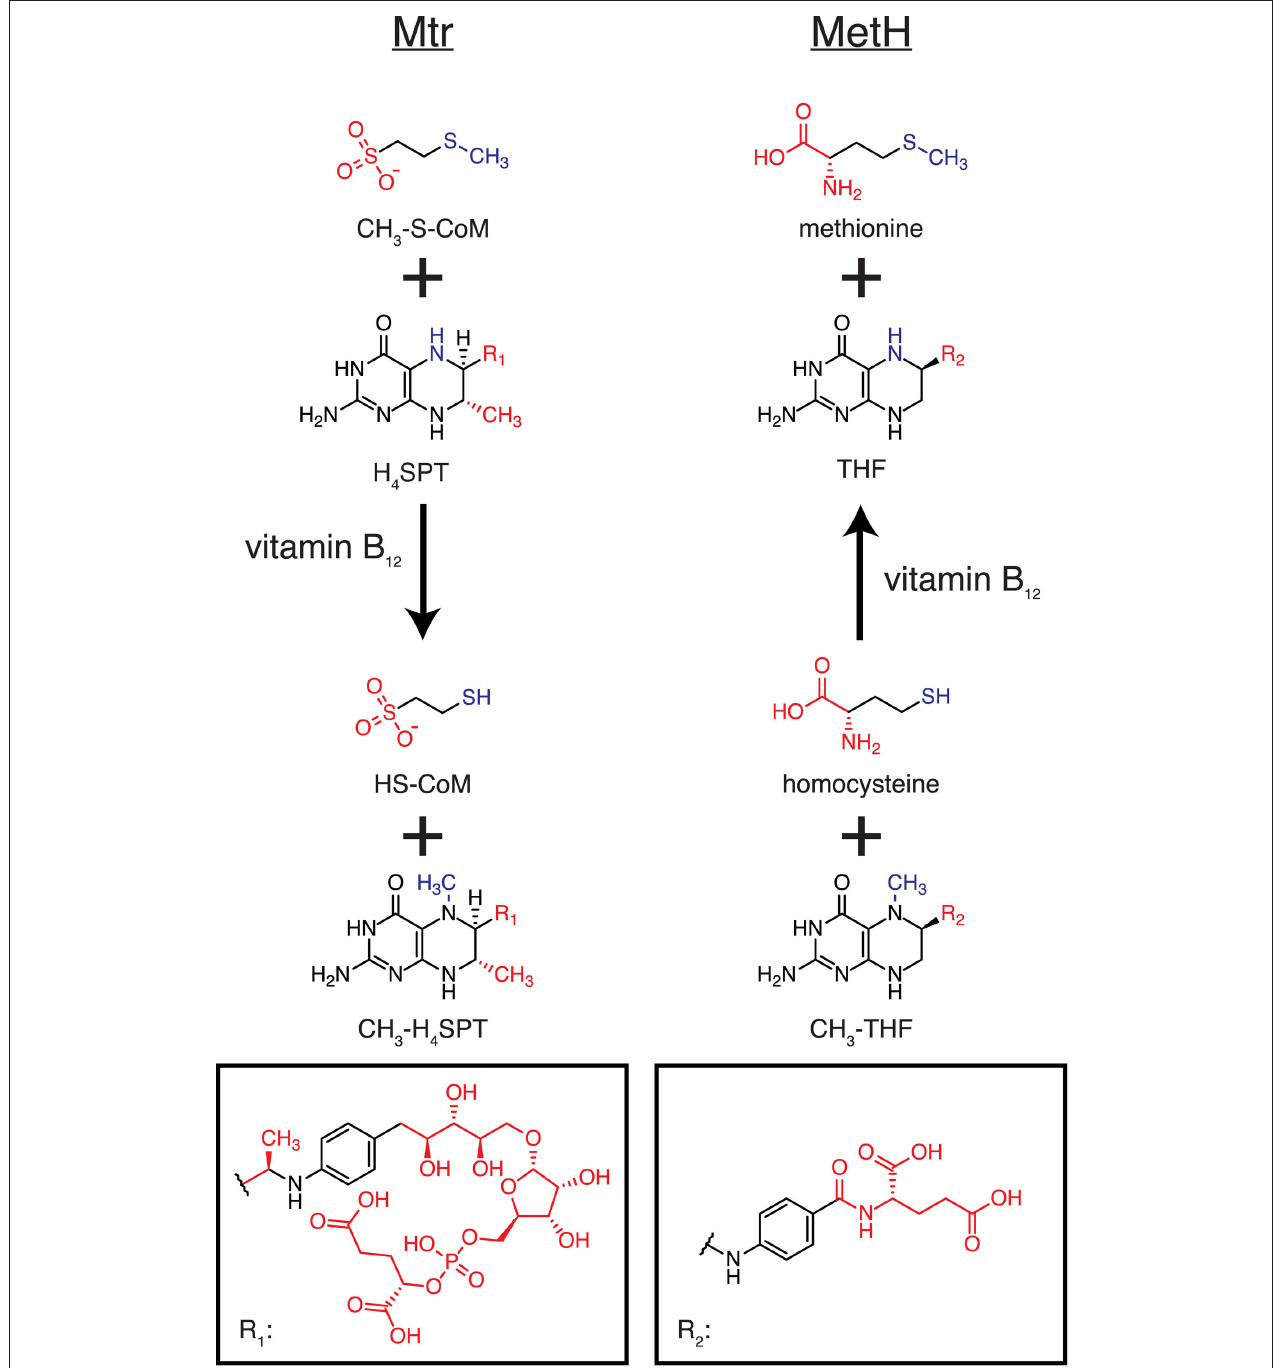
FIGURE 8 | Homologous reactions catalyzed by Mtr and MetH. The left column illustrates the reaction catalyzed by Mtr (and CmtA), while the right columns shows the reaction catalyzed by MetH. The reactive portions of each molecule are colored blue, and the differences between Mtr and MetH substrates/products shown in red.